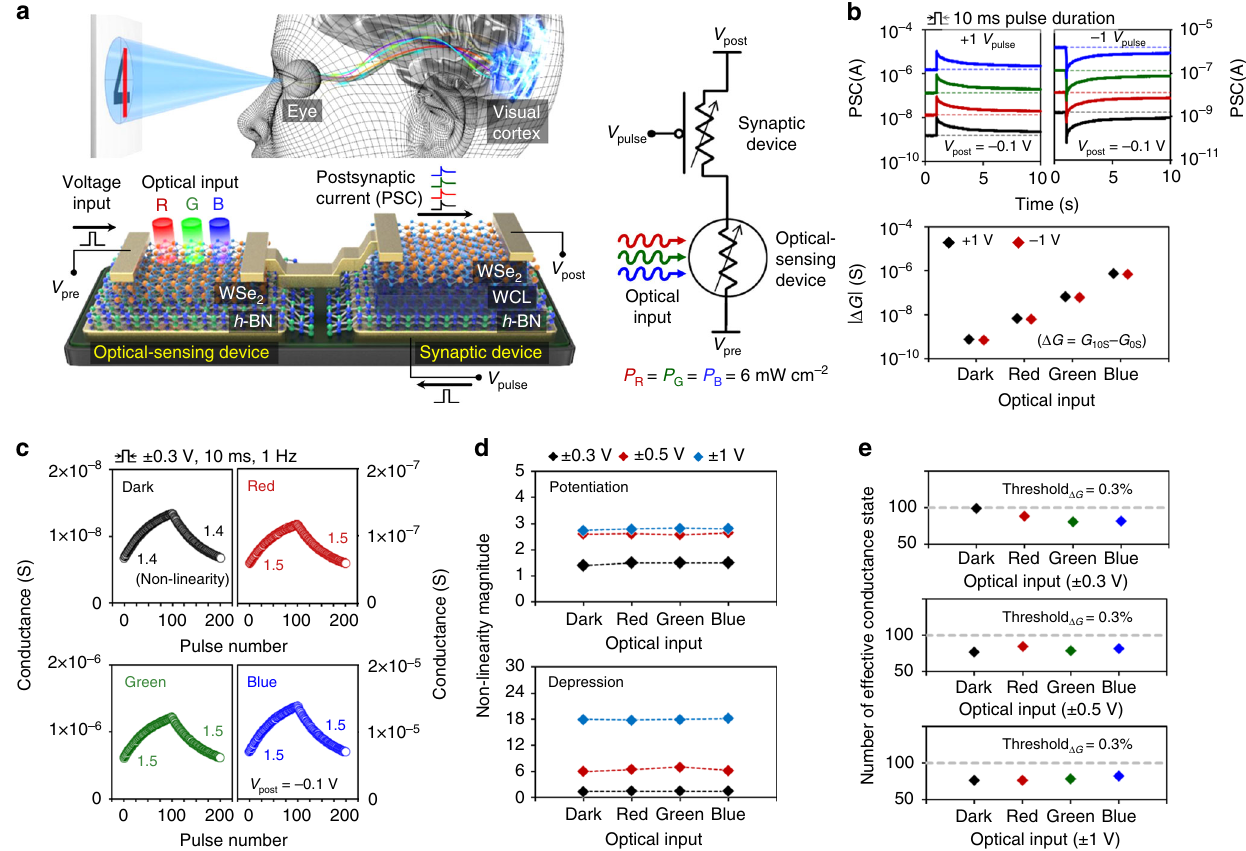
Fig. 1 Integration of the h -BN/WSe 2 optic-neural synaptic device. a Schematic of the human optic nerve system, the h -BN/WSe 2 synaptic device integrated with h -BN/WSe 2 photodetector, and the simpli fi ed electrical circuit for the ONS device. Here, the light sources were dot lasers with wavelengths of 655 nm (red), 532 nm (green), and 405 nm (blue) with a fi xed power density ( P ) of 6 mWcm − 2 for all wavelengths. b Excitatory and inhibitory postsynaptic current characteristics and extracted conductance changes of the h -BN/WSe 2 ONS device under different light conditions (no light and RGB). c Long-term potentiation and depression curves under different light conditions, where the synaptic device is controlled using input pulses with an amplitude of 0.3 V. d , e Nonlinearity magnitude ( d ) and the number of effective conductance states (threshold Δ G = 0.3%) ( e ), which were extracted for different